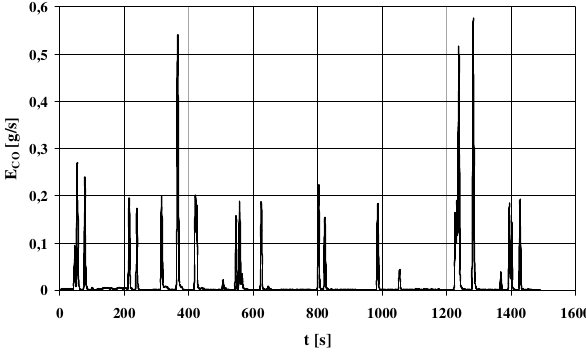
Fig. 8. The relative torque variation coefficient in the NEDC and Malta Fig. 12. The emission intensity of carbon monoxide in the Malta test tests